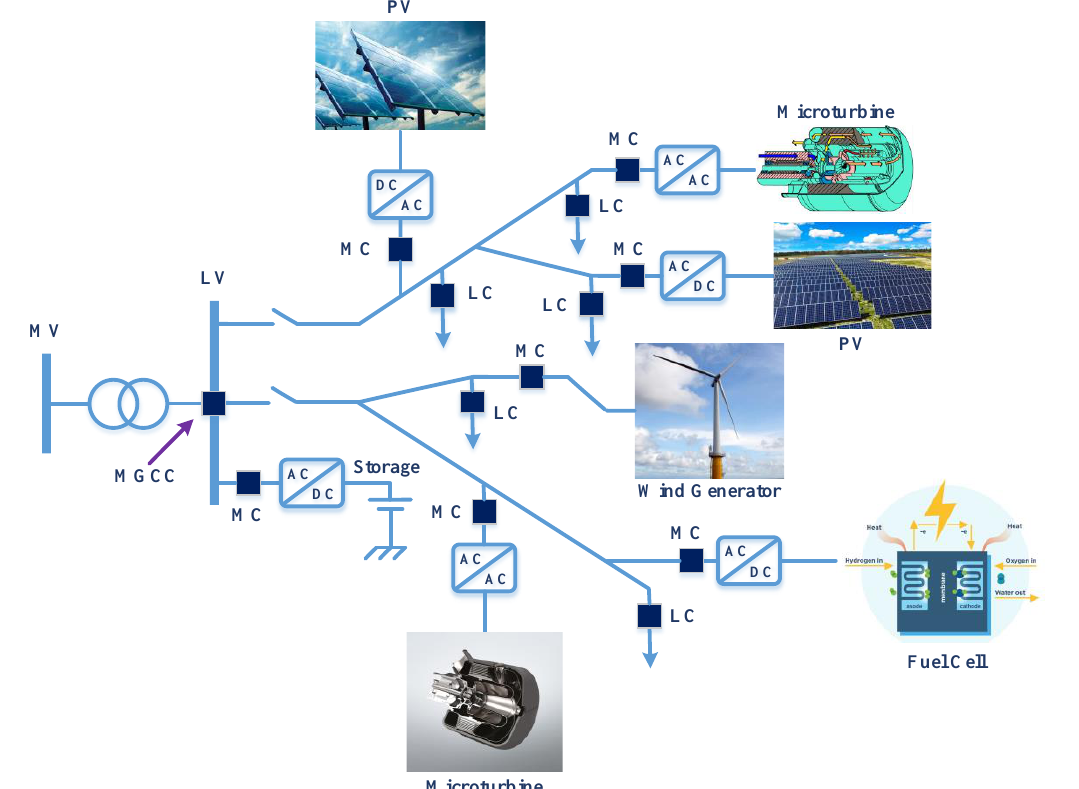
Figure 1. A typical LV-MG model.